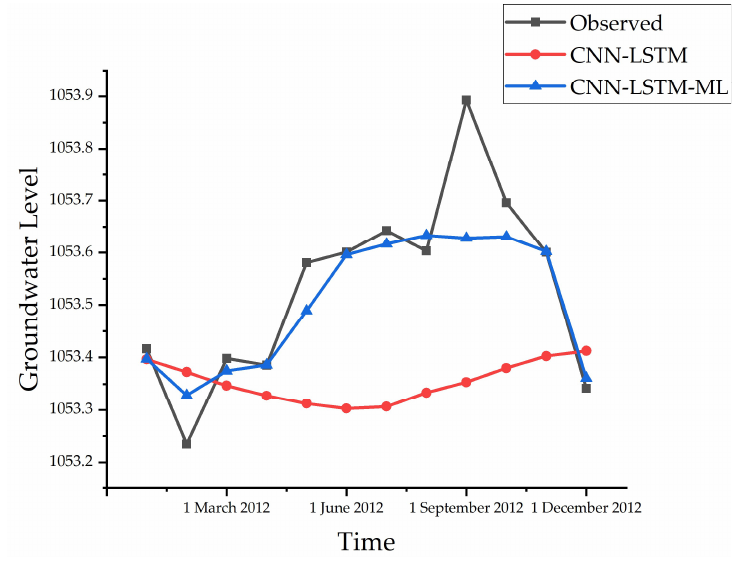
Figure 11. Visualization of ablation experiment prediction results.